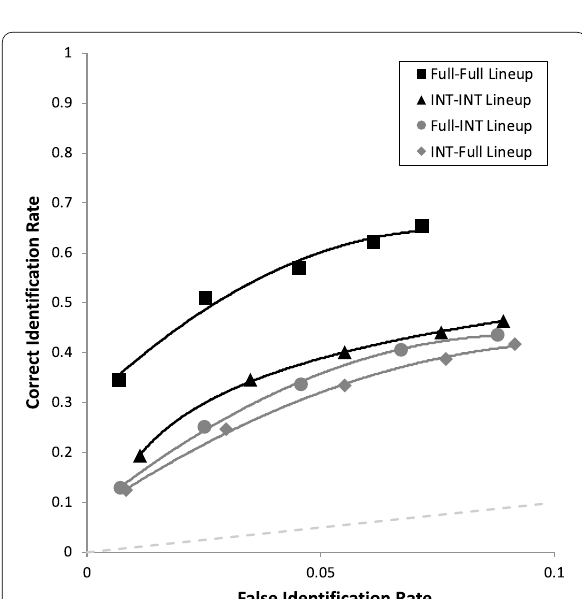
Fig. 8 ROC curve for each lineup condition broken down by encoded and test face type. Full For example, Full-INT represents a full face presented at